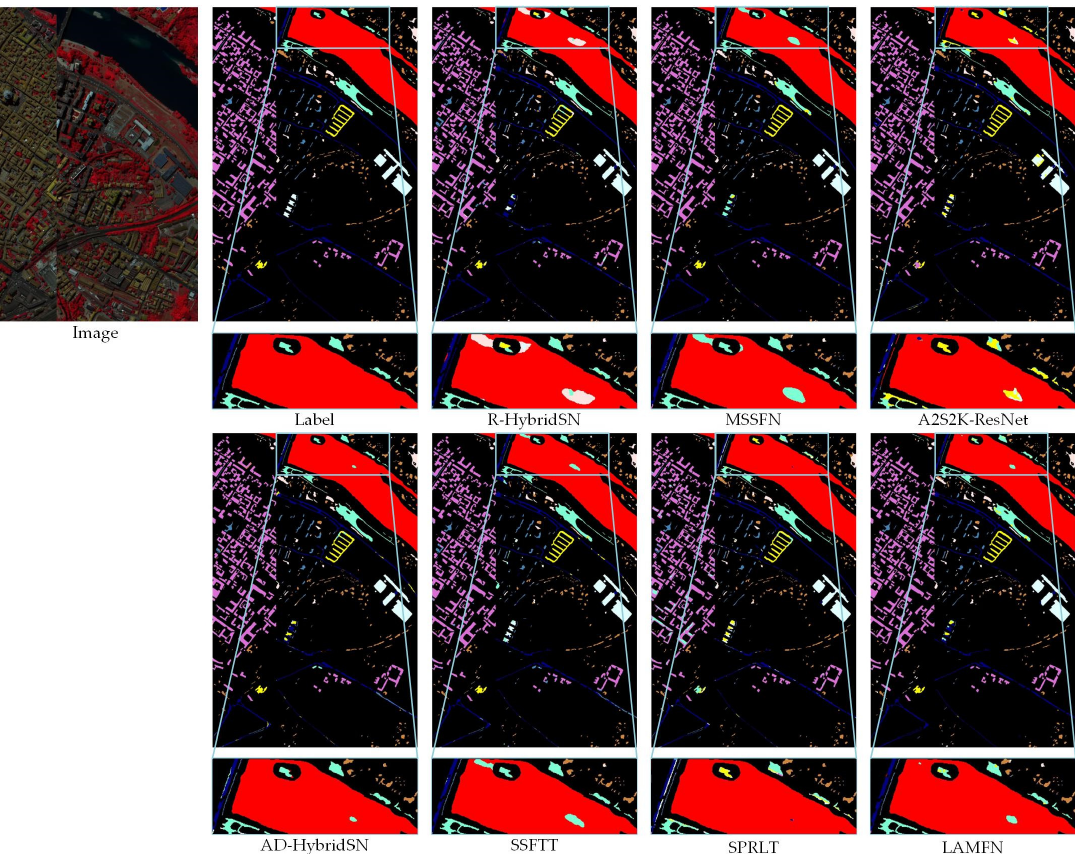
Figure 6. Classification maps of all models for PC dataset.